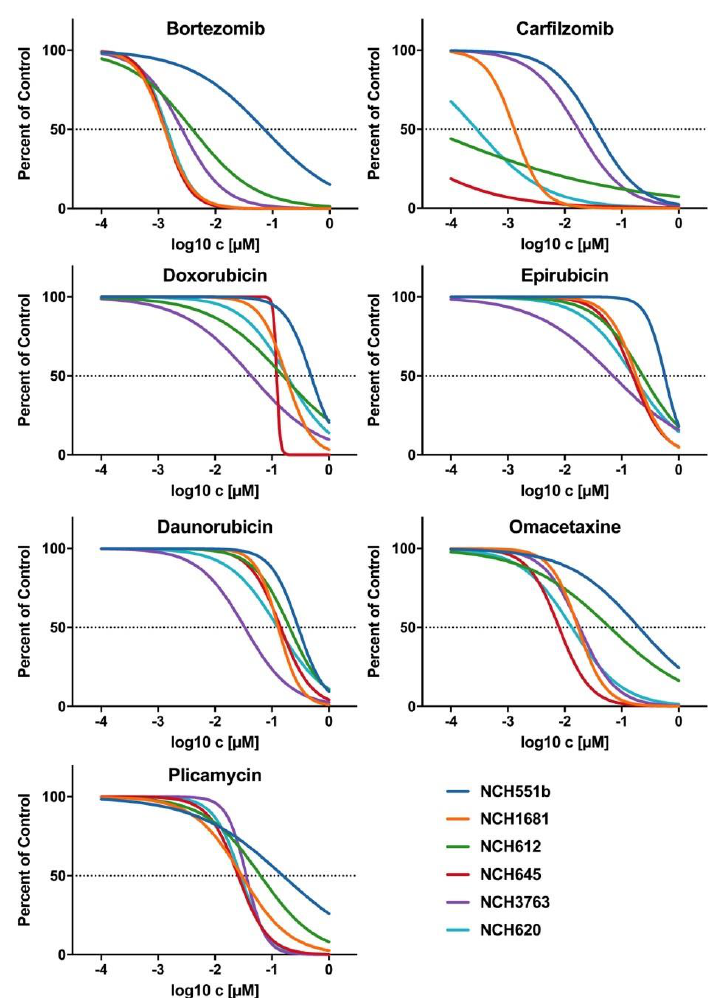
Figure 4. Representative dose response curves of candidate drugs for all six IDH mut GSC lines. The proteasome inhibitors, bortezomib and carfilzomib, showed the biggest variance in IC 50 , whereas the anthracylines (doxorubicin, daunorubicin, and epirubicin), as well plicamycin and omacetaxine, showed a range of IC 50 within a power of 10. All candidate drugs had an IC 50 < 1µM and a high maximum inhibitory effect of E max ≤ 17%.